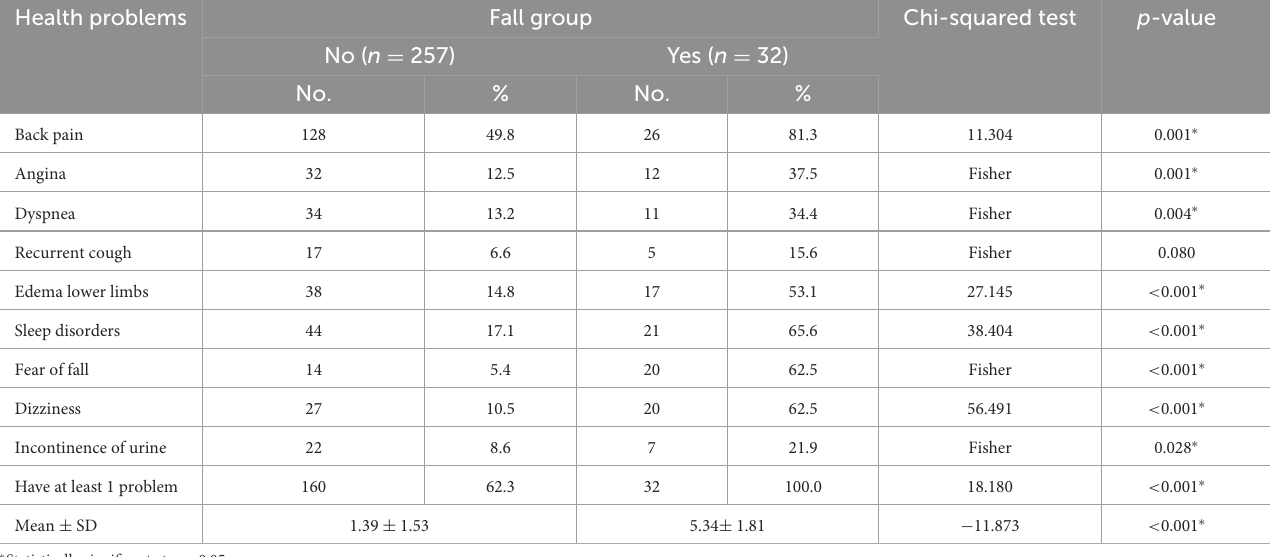
TABLE 4 Comparison of health problems reported by old age persons with and without fall history.